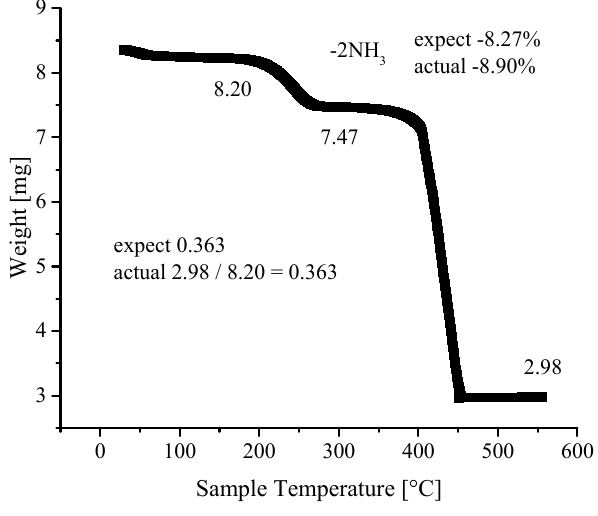
Figure 24. TGA scan in air for neat crystals of Ni-Bpy. Loss of coordinated NH 3 occurs over the temperature range of 200 °C to 300 °C. The “expected” value on the plot is the expected ratio of the mass of residual NiO to the mass of the framework as determined from the structure determined by single-crystal X-ray diffraction, whereas the “actual” ratio is the experimentally determined value taken at the indicated points in the scan. See Experimental Section for an explanation of how the ratio is calculated.